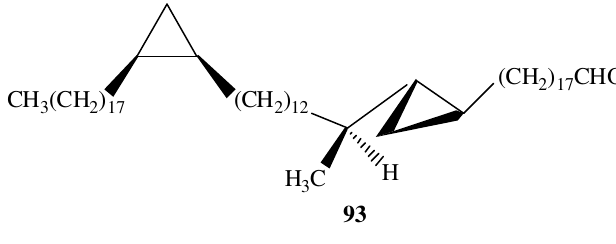
FIGURE 6. Structure of α -methyl-trans-cyclopropane unit 93 .